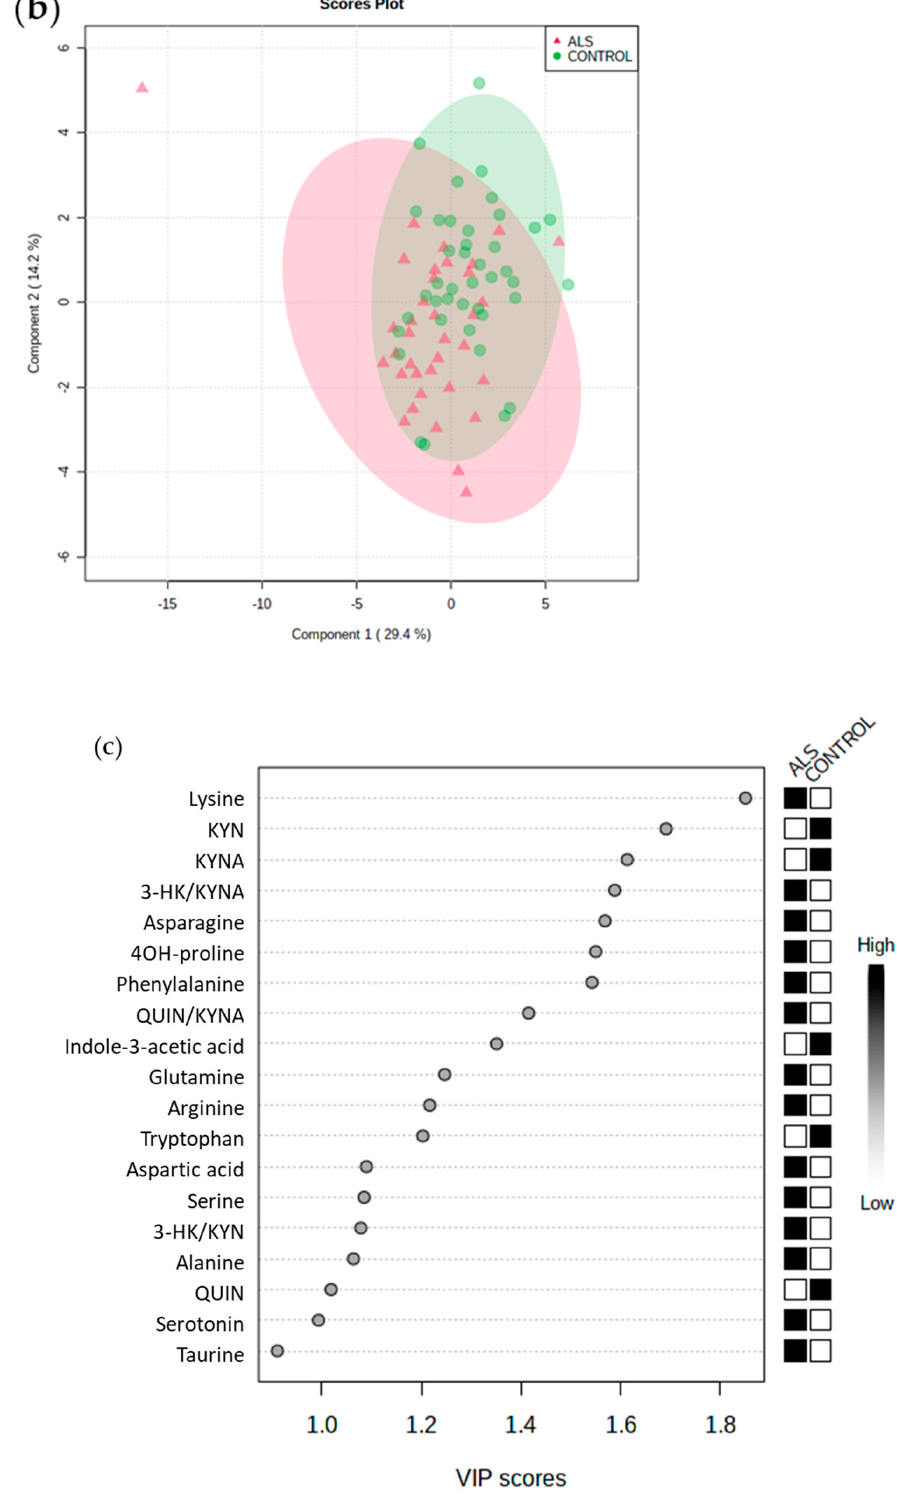
Figure 2. Multivariate analysis of CSF amino acids and tryptophan catabolism metabolites in ALS and control subjects. ( a ) Volcano plot representing the most important features in univariate analysis. Red dots indicate an increase of the feature in ALS patients compared to controls and blue dots a decrease; ( b ) scores plots of the PLS-DA model. Red triangles represent ALS patients and green dots control subjects. ( c ) Important features (VIP > 0.8) identified by PLS-DA, the boxes on the right indicate the relative concentrations of the corresponding metabolite in each group.